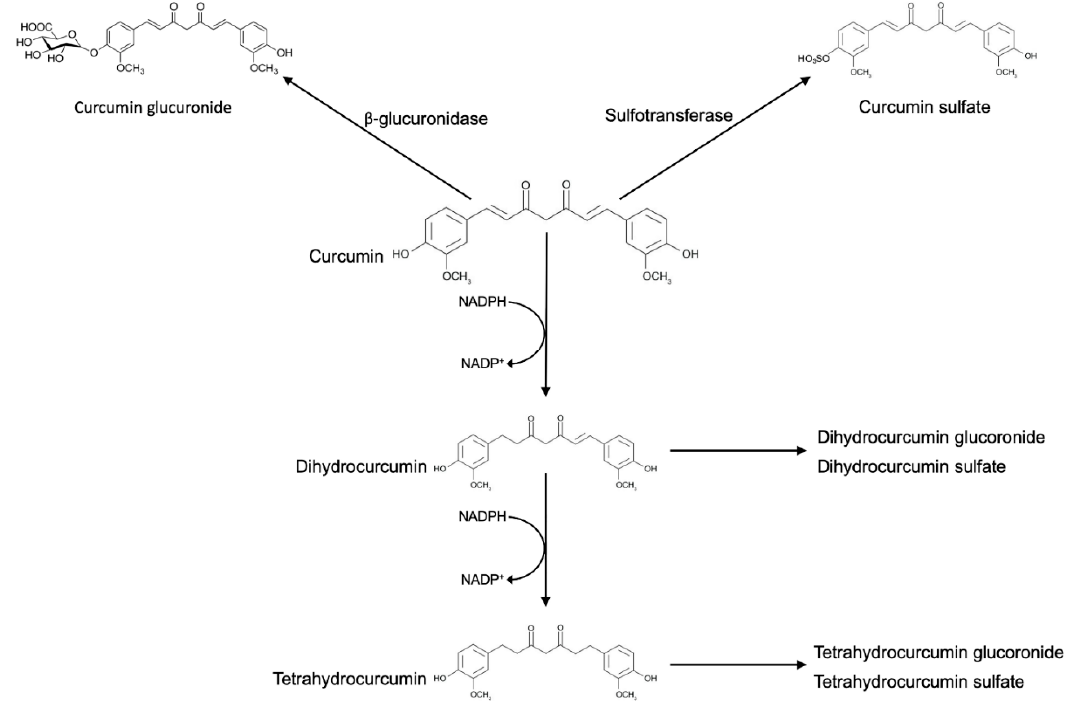
Figure 1. Reductive and conjugative metabolism of curcumin. Glucuronidation and sulfation are the predominating pathways of conjugation. Curcumin is also reduced by endogenous reductase systems